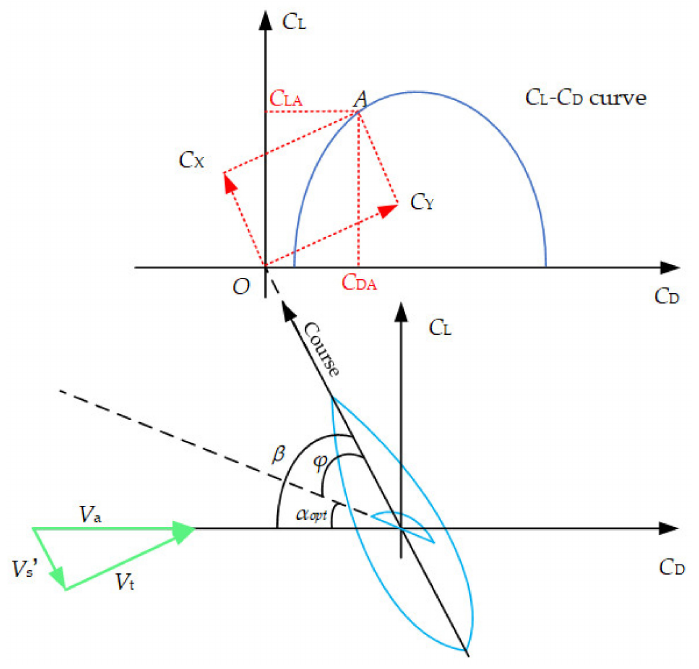
Figure 3. Force analysis of wing sails.